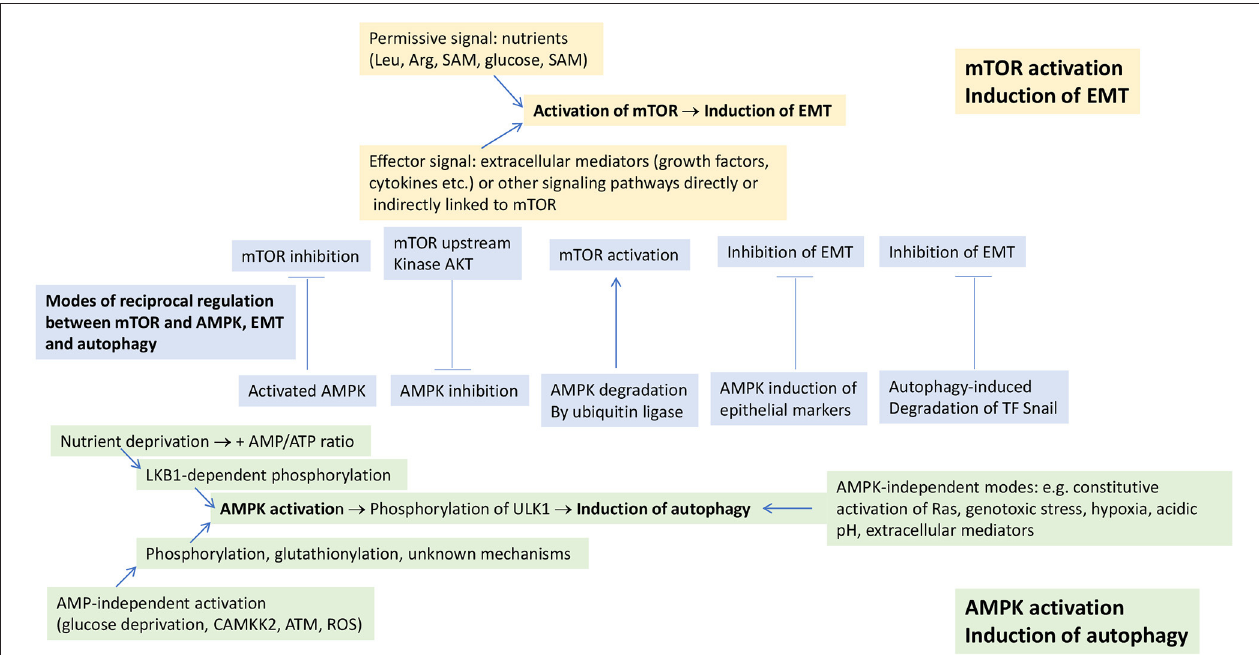
FIGURE 1 | Modes of induction of EMT and autophagy. EMT is induced in response to mTOR activation, which requires two signals for activation: a permissive signal represented by nutrients and an effector signal represented by extracellular mediators and/or other signaling pathways which are directly or indirectly linked to mTOR. Autophagy is induced in response to AMPK activation or to a diverse array of stimuli, independently of AMPK activation. mTOR and AMPK undergo negative, reciprocal regulation (shown in the central part of the figure). Some of the mechanisms underlying the negative, reciprocal regulation between EMT and autophagy that can occur independently of any involvement of mTOR and AMPK are also shown in this part of the figure. See text for further details. ATM, ataxia teleangectasia mutated; CAMKK2, calcium-sensitive kinase calmodulin-dependent protein kinase kinase 2; Rheb, Ras homolog enriched in brain; ROS, reactive oxygen species; SAM,